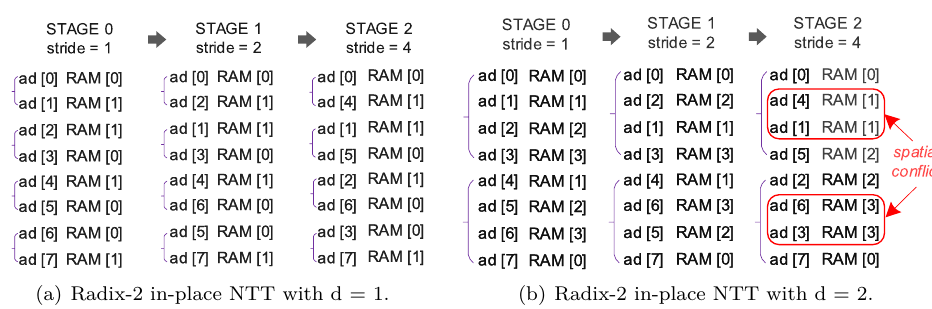
Figure 2: The spatial conflict in 8-point radix-2 in-place